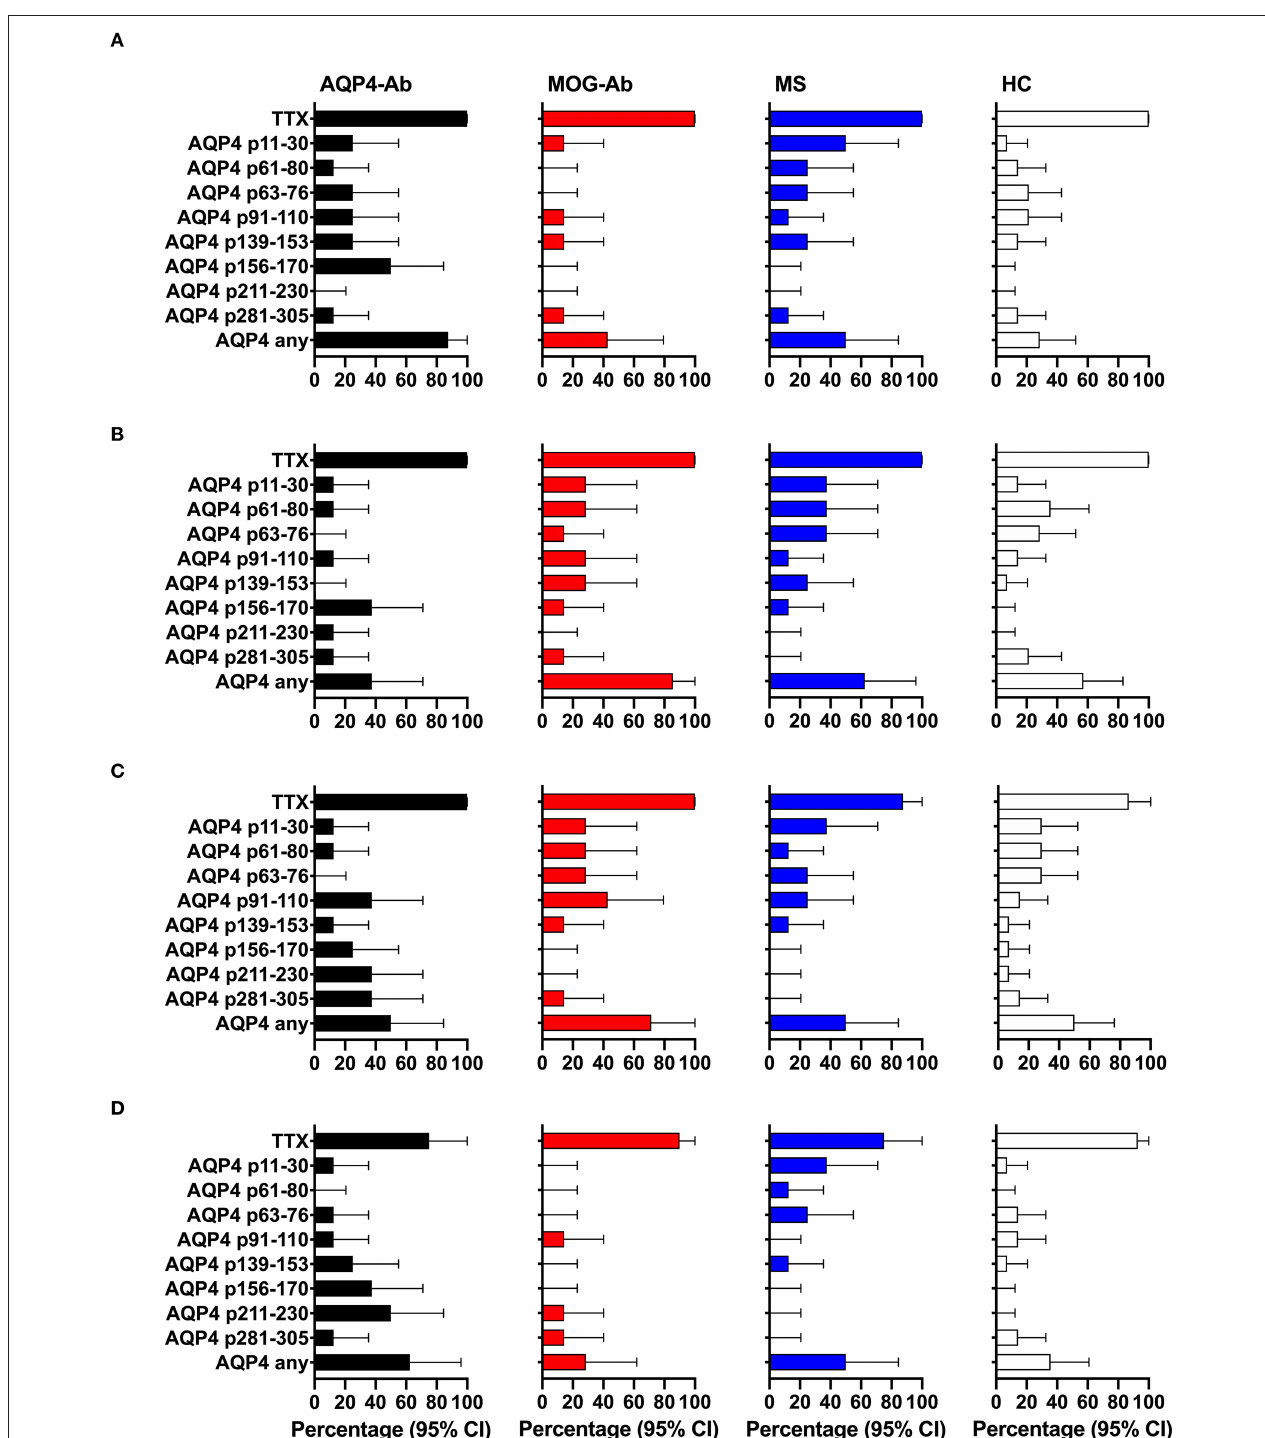
FIGURE 4 | CD4 + T-cell reactivity to AQP4 peptides in participants with AQP4-Ab ( n = 8), MOG-Ab ( n = 7), MS ( n = 8) and HC ( n = 14). (A) percentage of participants with positive CD4 + T-cell proliferation (CDI ≥ 3) after challenging with respective AQP4 peptides and the positive control TTX. Percentage of participants with positive secretion (SI ≥ 3) of GM-CSF (B) , IFN- γ (C) and IL-6 (D) after challenging with respective AQP4 peptides and the positive control TTX. The 95% confidence intervals are indicated by the error bars. AQP4-Ab, aquaporin-4 antibody positive; CDI, cell division index; GM-CSF, granulocyte-macrophage-colony-stimulating factor; HC, healthy controls; IFN, interferon; IL, interleukin; MOG-Ab, myelin oligodendrocyte glycoprotein antibody positive; MS, multiple sclerosis; SI, stimulation index; TTX, tetanus toxoid.